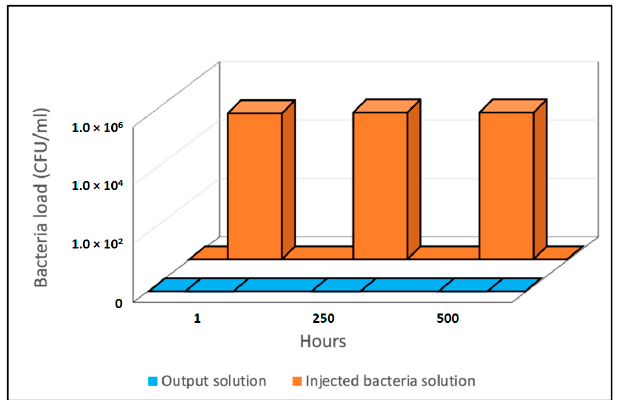
Figure 8. Results of the antibacterial test in the continuous-flow column water disinfection experiment.